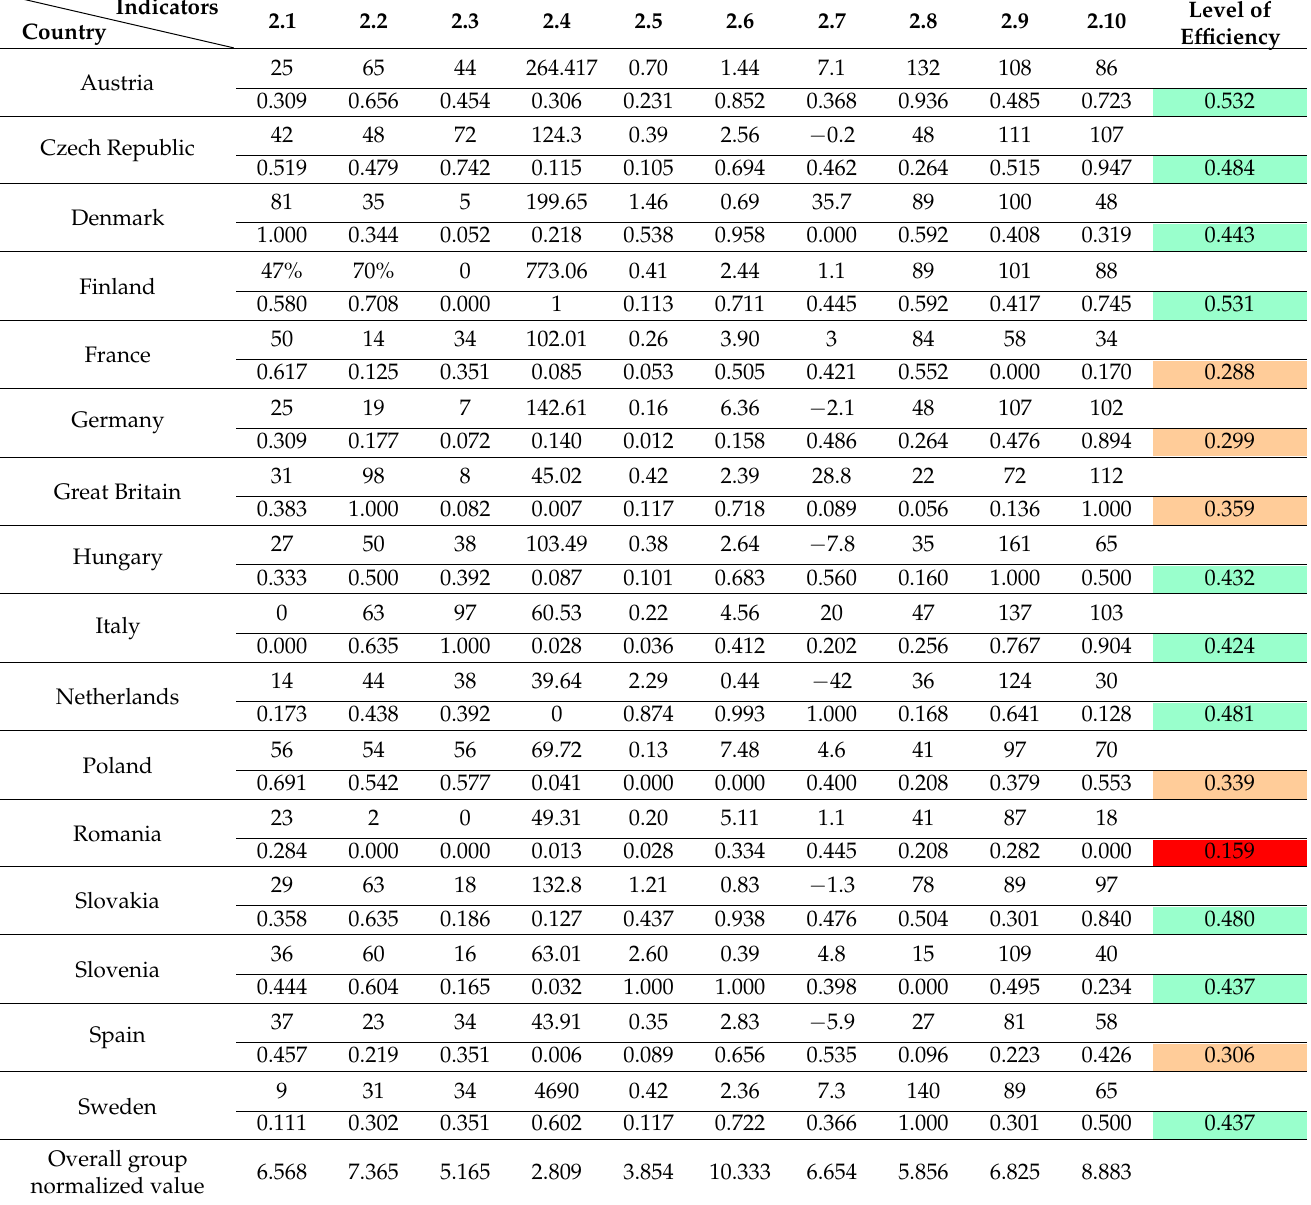
Table 4. Level of efficiency in the bioenergy